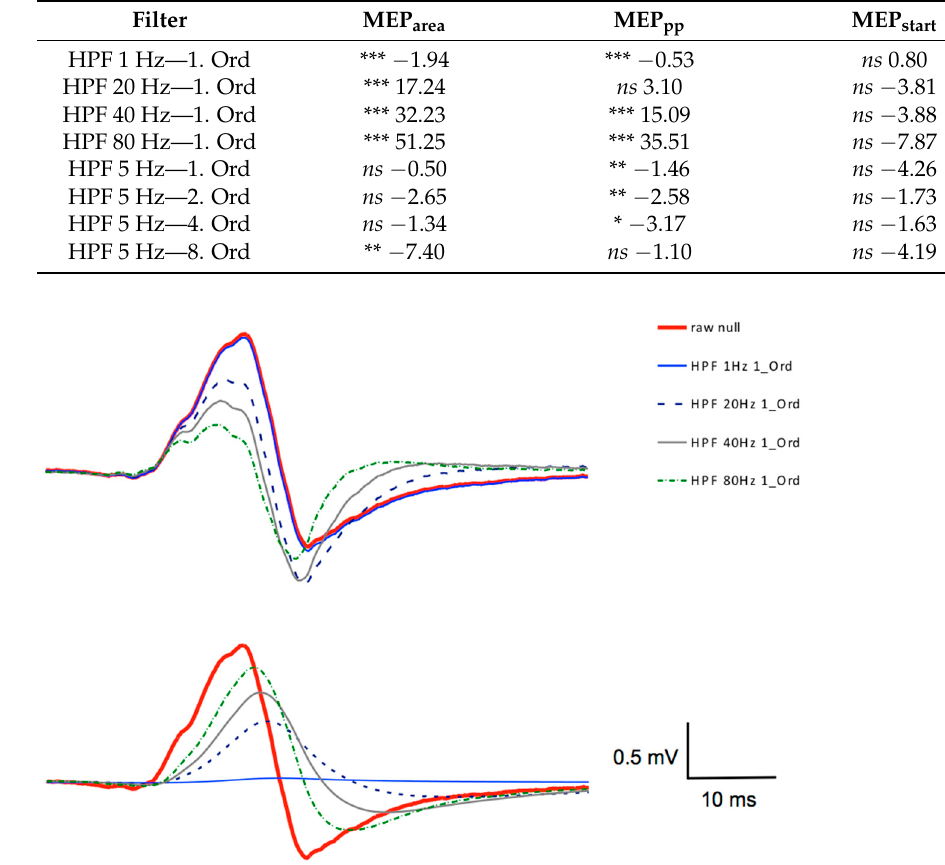
Table 1. In response to the different filter settings, the absolute percentage differences ( Δ %) of the MEP-parameter between the raw data and the filtered signals are shown in the table. Significant differences in MEP characteristic parameters are presented. ns = not significant, * p < 0.05, ** p < 0.01, *** p < 0.001.